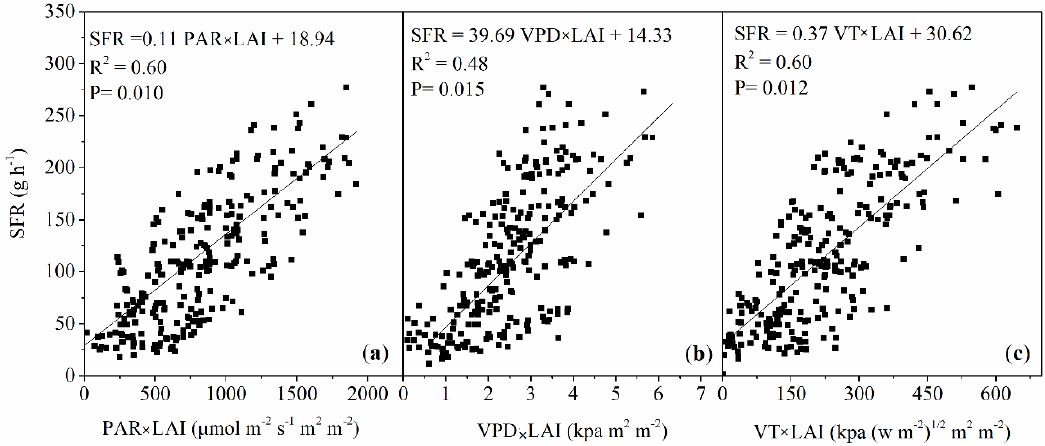
Figure 5. Relationship between daily sap flow rate (SFR) and three integrated indexes—photosynthetically active radiation by leaf area index (PAR × LAI, ( a )), vapor pressure deficit by leaf area index (VPD × LAI, ( b )) and variable transpiration by leaf area index (VT × LAI, ( c ))—in 2017 and 2018 experimental